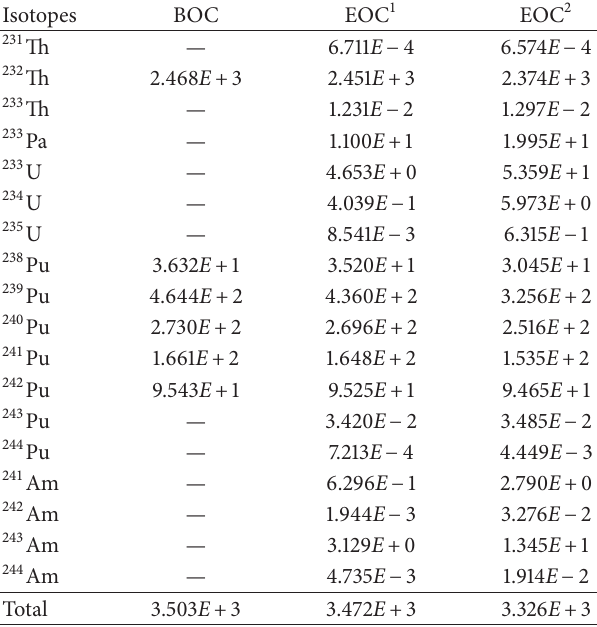
Table 7: Masses of actinide isotopes [kgHM] at the beginning and at the end of the cycle (Case 2).